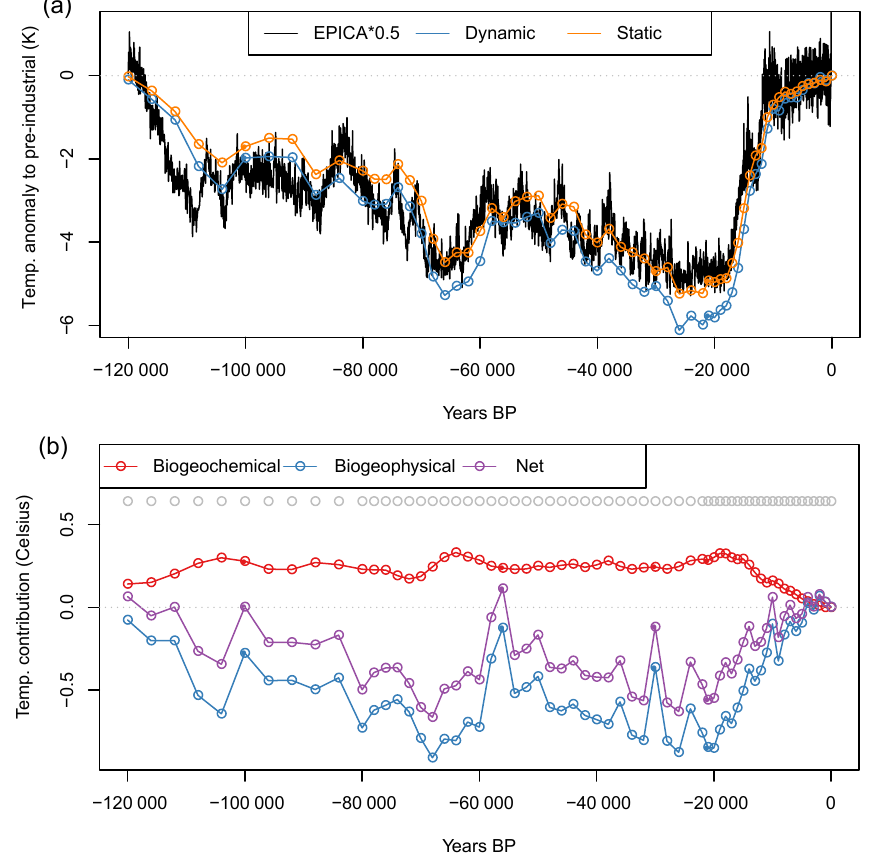
Figure 2. (a) Global mean annual temperature (degrees Celsius at 1.5m) for Static vegetation simulation (orange); Dynamic vegetation (blue); and the EPICA core-inferred temperature data (black), halved (to give an approximation of global temperature over the whole period). Time periods of particular interest are highlighted as filled points: 21, 30, 56, 68, and 100ka. (b) Temperature anomaly over time of Dynamic– Static simulations for biogeochemical temperature effects of the vegetation change, calculated with GENIE, averaged to the same temporal resolution as the HadCM3 simulations (red); biogeophysical temperature effects of vegetation change (blue); and the net (biogeophysical and biogeochemical) effect of vegetation on temperature (purple). Grey points show the time points of the HadCM3